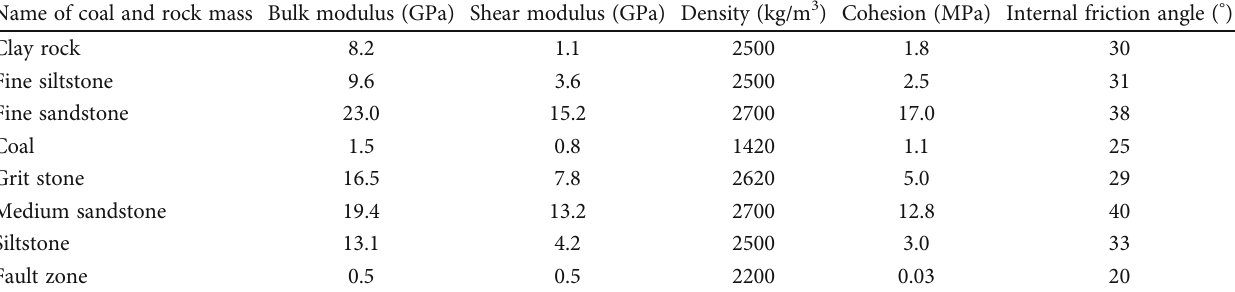
Table 1: Physical and mechanical parameters used in the model.